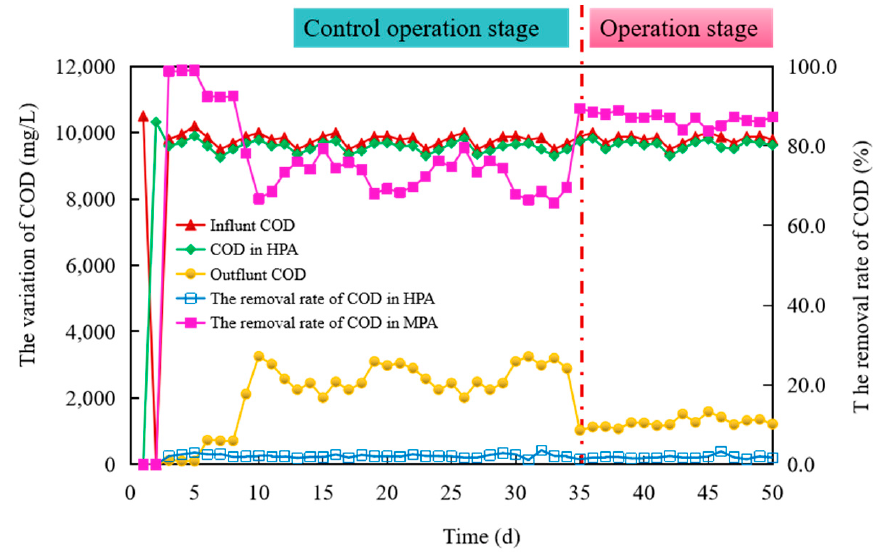
Figure 5. Variation in the chemical oxygen demand (COD) and removal rate during biohythane production process.